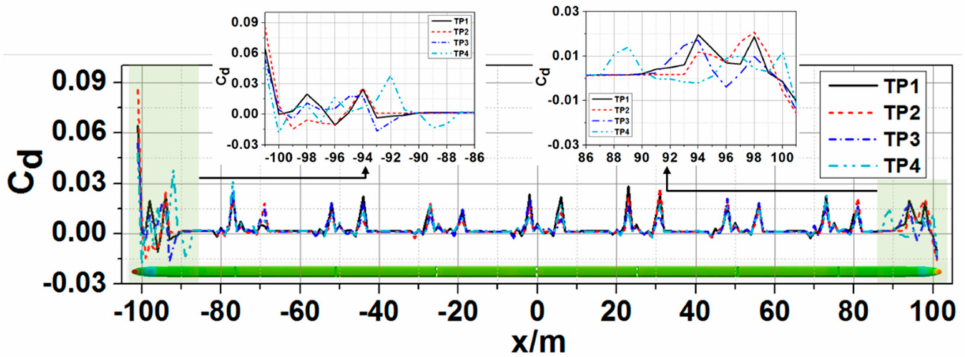
Figure 12. Plots of Cd on four nose shapes along the x axis at t = 2 s. Time-averaged Cd of the four models is given in Table 3. From the given data it can be seen that the whole Cd of TP1 is the highest while that of TP4 is the lowest, dropping by 4.2% compared to TP1. On the other hand, the whole Cd of TP2 and TP3 remains close to each other. Specifically, Cd of the leading car of TP2 is the smallest while that of the trailing car is the largest among the four models. For TP3, the Cd of the leading car is the largest while that of the trailing car is close to TP4. The Cd of the middle carriages for TP2 and TP3 remain close to each other, which is in accordance with the drag distribution shown in Figure 10b. The Cd of the leading car for TP4 increases by 3.2% to TP2. However, the Cd of middle carriages and the trailing car is the smallest among all the models. Although the aerodynamic drag coefficients of streamlined head and tail are almost similar for TP1 and TP3, the Cd of middle carriages for TP1 is relatively larger than TP3. It could be concluded that when performing drag reduction of a high-speed train, not only the drag of the leading and trailing streamlines should be considered, but also the streamlined variation influence on the middle carriages. In brief, the drag reduction design should aim at the drag of the whole